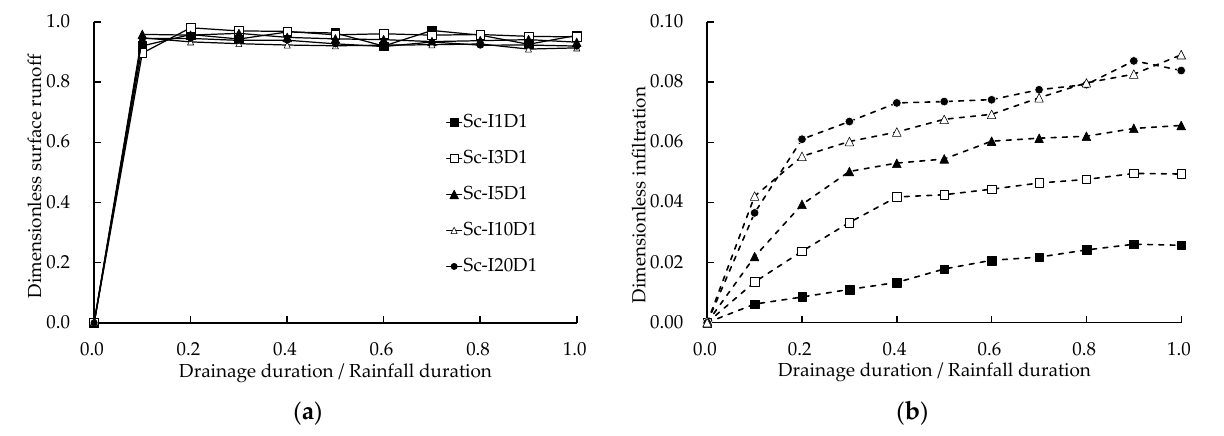
Figure 10. Results of scaled model simulation for 100 s: ( a ) surface runoff; ( b ) infiltration.